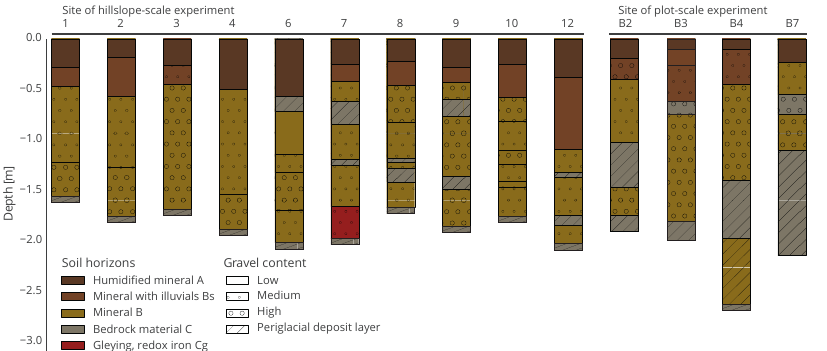
Figure 5. Soil core profiles from the upper Colpach River basin. See Figs. 3 and B1 for positions. Bar depth is the maximum drilling depth of the cores restricted by large stones or bedrock.